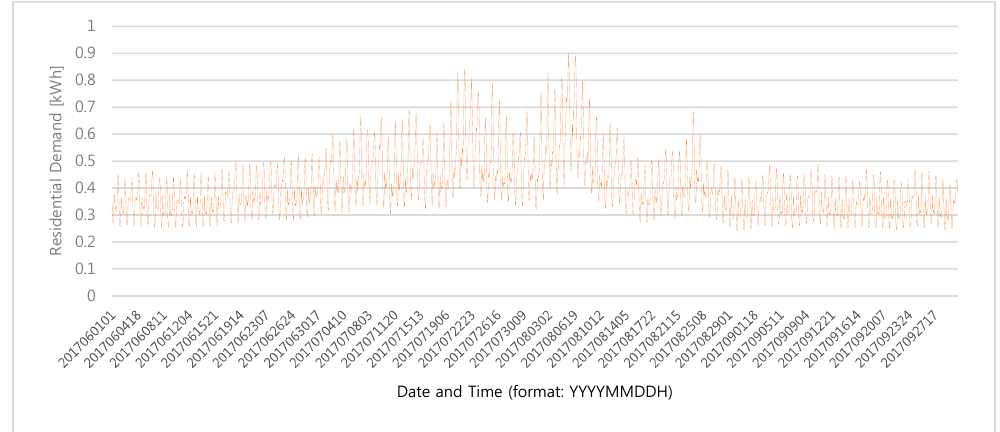
Figure 2. Average hourly demand for residential peak-time rebate (PTR) program customers in Seoul, Korea, from June through September.